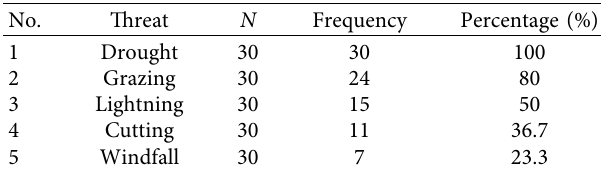
Table 1: Major threats to D. glabra